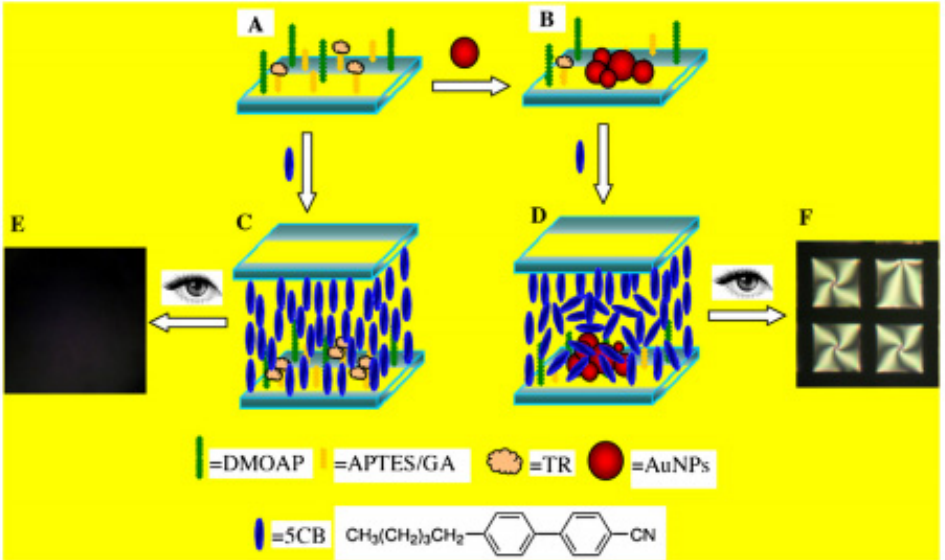
Figure 9. Illustration diagram of detection strategy of LC biosensor: ( A ) cimmobilization of TR; ( B ) deposition of AuNPs through the enzymatic process; ( C ) homeotropic orientation of 5CB in the cells without AuNPs on glass slides; ( D ) the disrupted orientation of 5CB in the cells with AuNPs deposited on glass slides. Photograph under polarized light microscope ( E ; F ) [30].